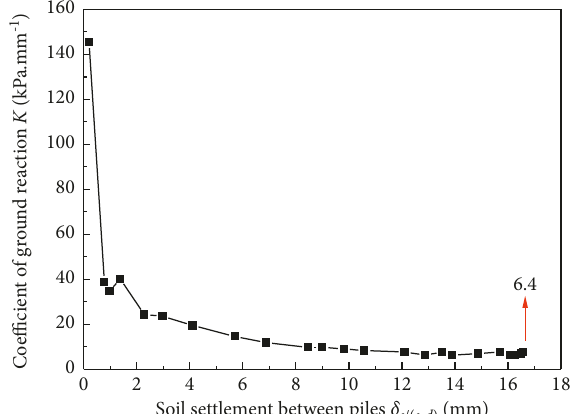
Figure 5: Relationship between average soil pressure σ tlement δ s between the piles and soil.